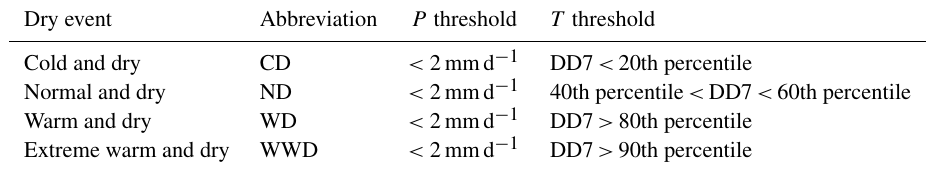
Table 1. Definitions of the different dry days. If 7 or more of these dry days follow each other up, it was classified as an event. Dry event Abbreviation P threshold T threshold Cold and dry CD < 2mmd − 1 DD7 < 20th percentile Normal and dry ND < 2mmd − 1 40th percentile < DD7 < 60th percentile Warm and dry WD < 2mmd − 1 DD7 > 80th percentile Extreme warm and dry WWD < 2mmd − 1 DD7 > 90th